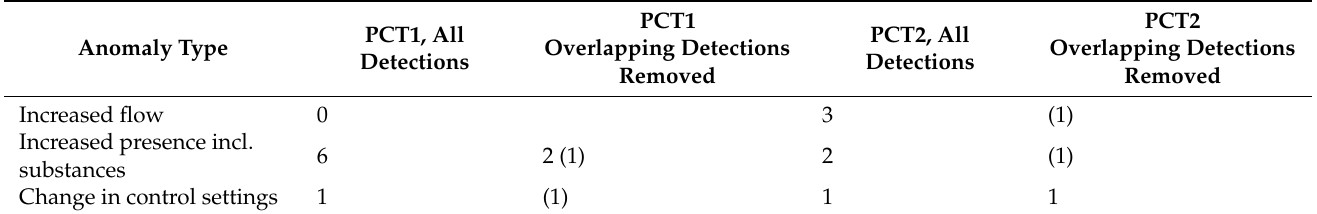
Table 4. Overview of anomaly types detected in WWTP3 for the two PCTs. The table shows how many of the different types of anomalies are detected in total for each of the PCTs. Furthermore, it shows how many anomalies are detected if anomalies present in both PCTs are removed. The numbers in parentheses are the number of anomalies which have some overlap with the other PCT, but the period of the detections is not